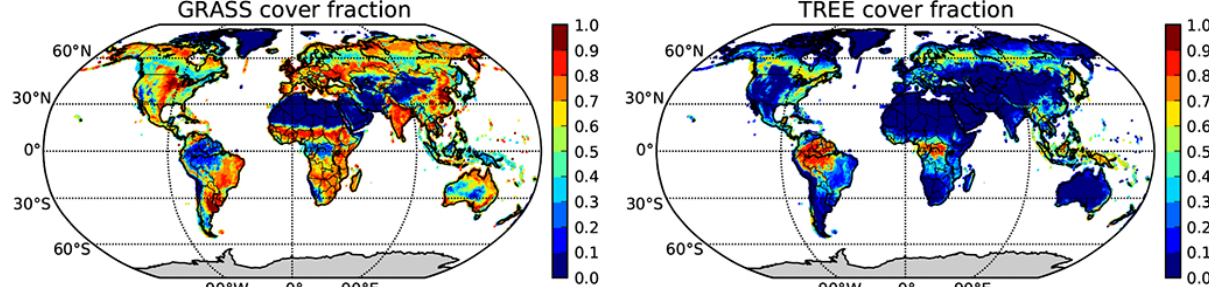
Fig. A3. PFT distribution for grassland and forests.